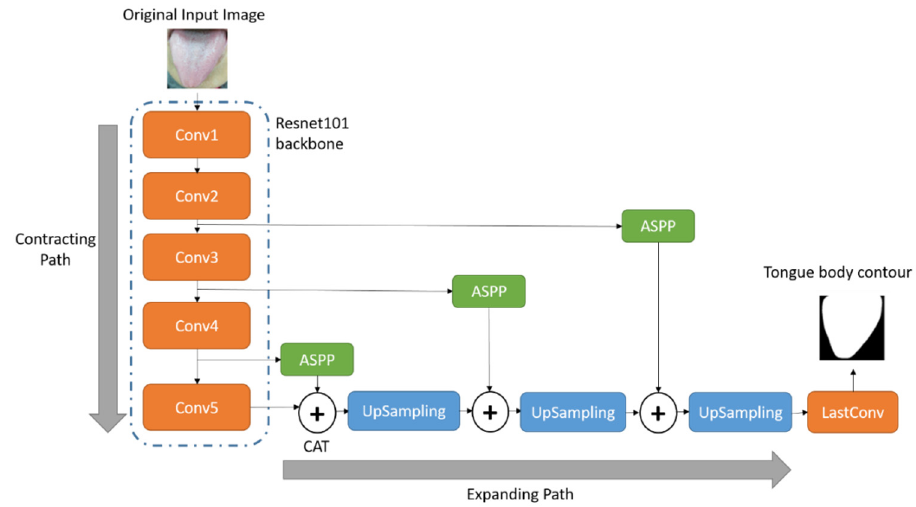
Figure 5. Overall architecture of semantic-based CNNs (SegTongue).